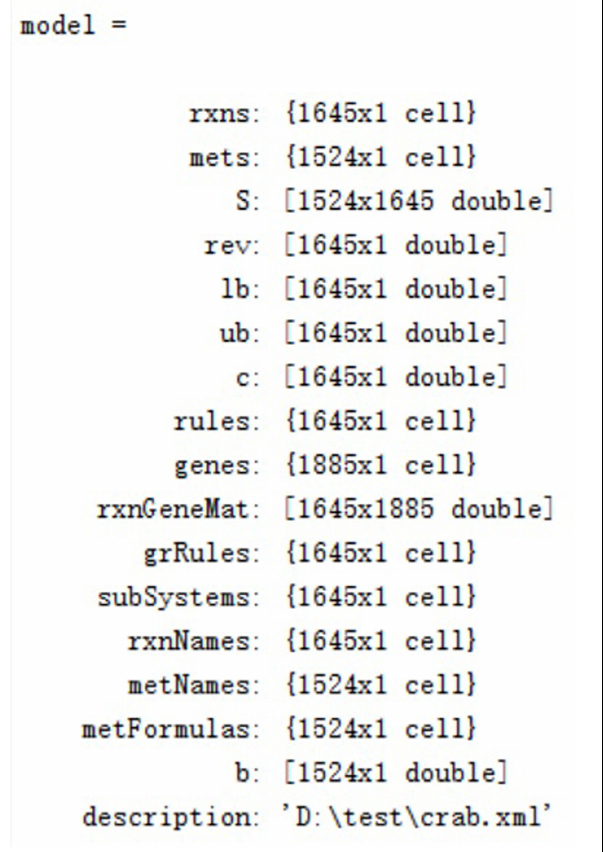
TABLE 1 | Content of each kind of nutrients in 100-g cells.